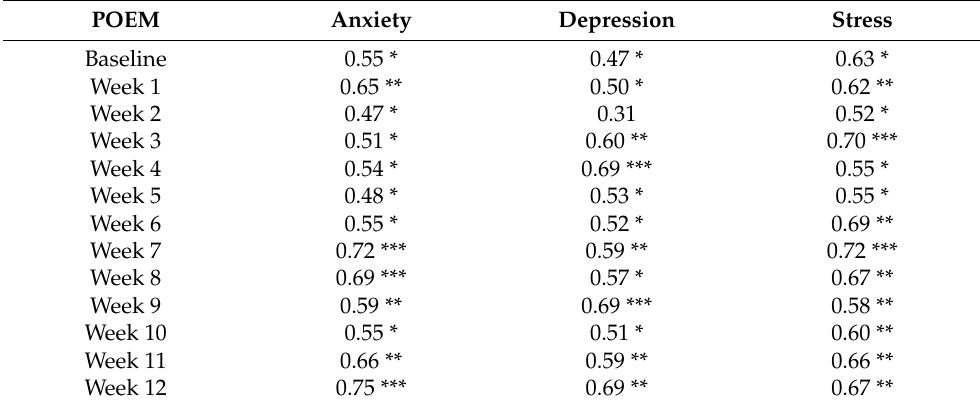
Table 1. Pearson’s correlations between atopic dermatitis severity and psychological variables. POEM Anxiety Depression Stress Baseline 0.55 * 0.47 * 0.63 * Week